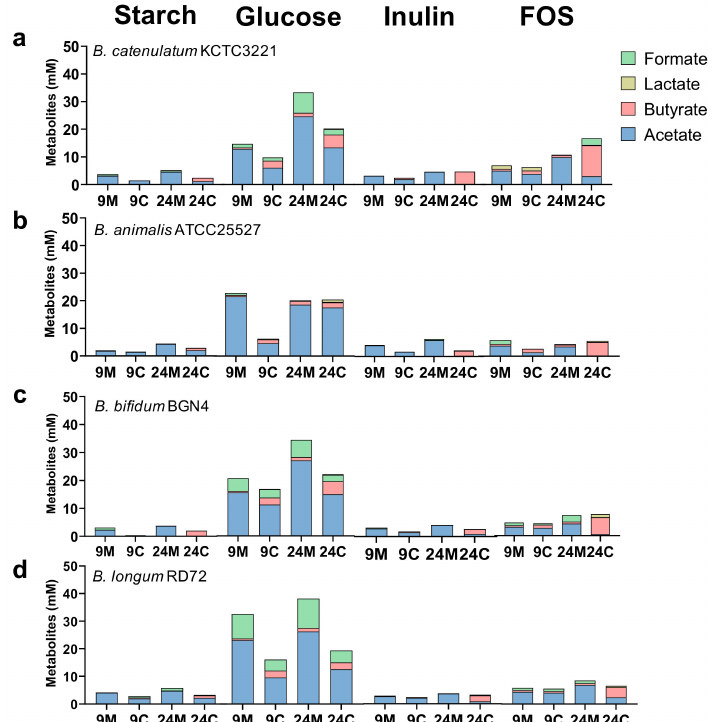
Figure 2. Production of SCFA by bacteria in monoculture and co-culture. Concentrations of SCFA (acetate, lactate, formate, and butyrate) were determined 9 and 24 h after inoculation. Data for F. prausnitzii in monoculture and in co-culture with B. catenulatum KCTC 3221 ( a ), B. animalis ATCC 25527 ( b ), B. bifidum BGN4 ( c ), and B. longum RD72 ( d ) are shown. All experiments were performed in YCFA medium without SCFA supplemented with starch, glucose, inulin, or FOS. The data are presented as the mean ( n = 3). 9M, metabolites from F. prausnitzii and Bifidobacterium monocultures after 9 h ; 9C, metabolites in F. prausnitzii and Bifidobacterium co-culture after 9 h; 24M, metabolites from F. prausnitzii and Bifidobacterium monocultures after 24 h; 24C, metabolites in F. prausnitzii and Bifidobacterium co-culture after 24